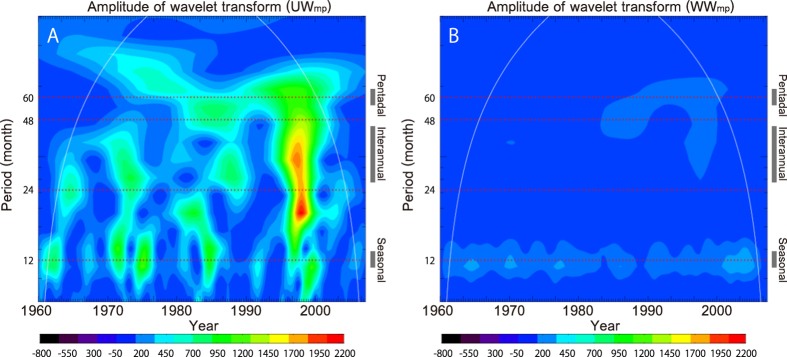
Magnitude of the wavelet transform of each component of the mean perturbation
wind power.(A) Adjustment wind power UWmp
(u′<τ>). (B)
Mature event wind power WWmp
τ′<u>24.